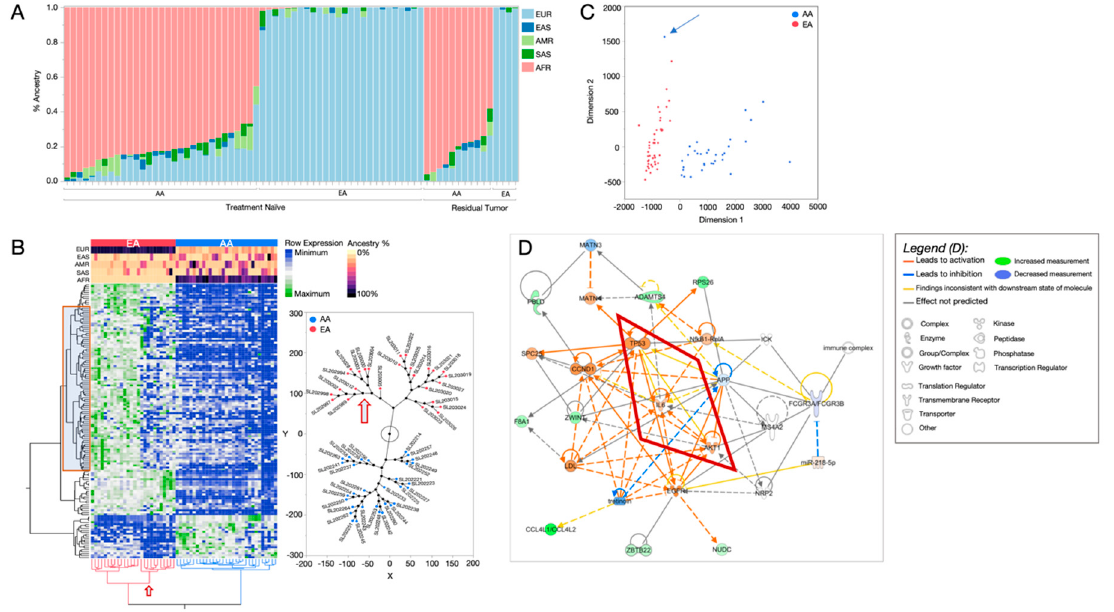
Figure 1. Differentially expressed genes (DEGs) associated with quantified genetic ancestry (QGA) in treatment-naïve TNBC RNA-seq. ( A ) QGA estimates for each cancer case, derived from RNAseq variants. Geographic ancestry super-group categories are indicated as European (EUR, light blue), East Asian (EAS, dark blue), American Native (AMR, light green), South Asian (SAS, dark green), and African (AFR, pink). Samples are grouped by treatment status (treatment naïve or residual tumor) and self-reported race (SRR). ( B ) Clustergram heatmap of the 156 ( p < 0.05) genes that show differential expression levels by QGA, where rows represent genes and columns represent individuals. SRR is shown in the top row of the color map (red indicating EA, and blue indicates AA); the remaining color map rows indicate ancestry estimations for each individual. The red box indicates genes that are associated with non-European admixture (EAS, SAS, and AMR). Constellation plot, right, representing the hierarchical structure of the individuals shown at the bottom of the heatmap. Red dots indicate SRR EAs; blue dots are SRR AAs. The red arrow points to the substrata of EA individuals with increased admixture; this corresponds to the non-European admixture genes in the red box of the heatmap. ( C ) Multidimensional analysis using 156 ancestry-associated genes indicates that the expression patterns separate individuals into SRR groups. Red indicates EA, and blue indicates AA. The blue arrow indicates an individual that self-reported as EA but has mostly AFR ancestry, clustering with the AA group. ( D ) De novo network analysis using QGA DEGs using Ingenuity Pathway Analysis (IPA) software. Molecules in green are upregulated in individuals with increased AFR ancestry; those in blue are downregulated in individuals with AFR ancestry. Molecules in orange are drawn into the network and predicted to be activated based on the state of DEGs in the network, using published interactions from the curated Ingenuity Knowledge Base. Orange lines between molecules indicate relationships leading to activation; blue lines indicate relationships leading to inhibition. Yellow lines indicate that the relationship between two molecules is not in the expected direction. For example, in this network TP53 is known to inhibit AKT1. TP53 is activated, and so it is expected that AKT1 would be downregulated. However, it is not. Because of this, the line showing the interaction between these two molecules is shown as yellow.